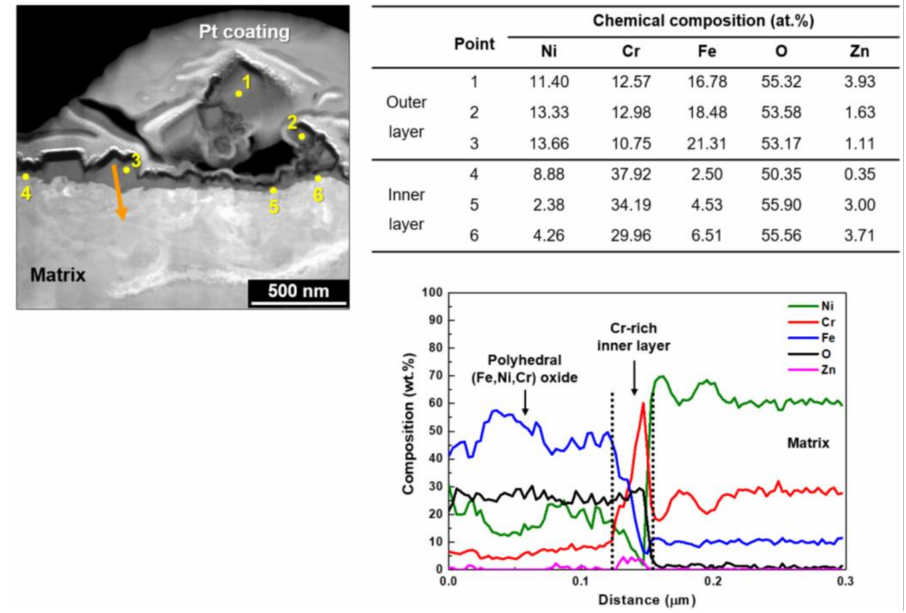
Figure 6. STEM image and EDS analyses of oxides grown on Alloy 690 under the Case #2